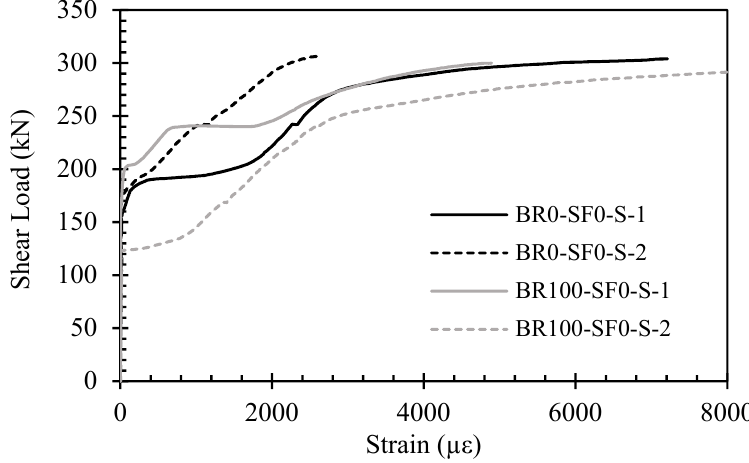
Figure 7. Shear load versus maximum stirrup strain relationships.